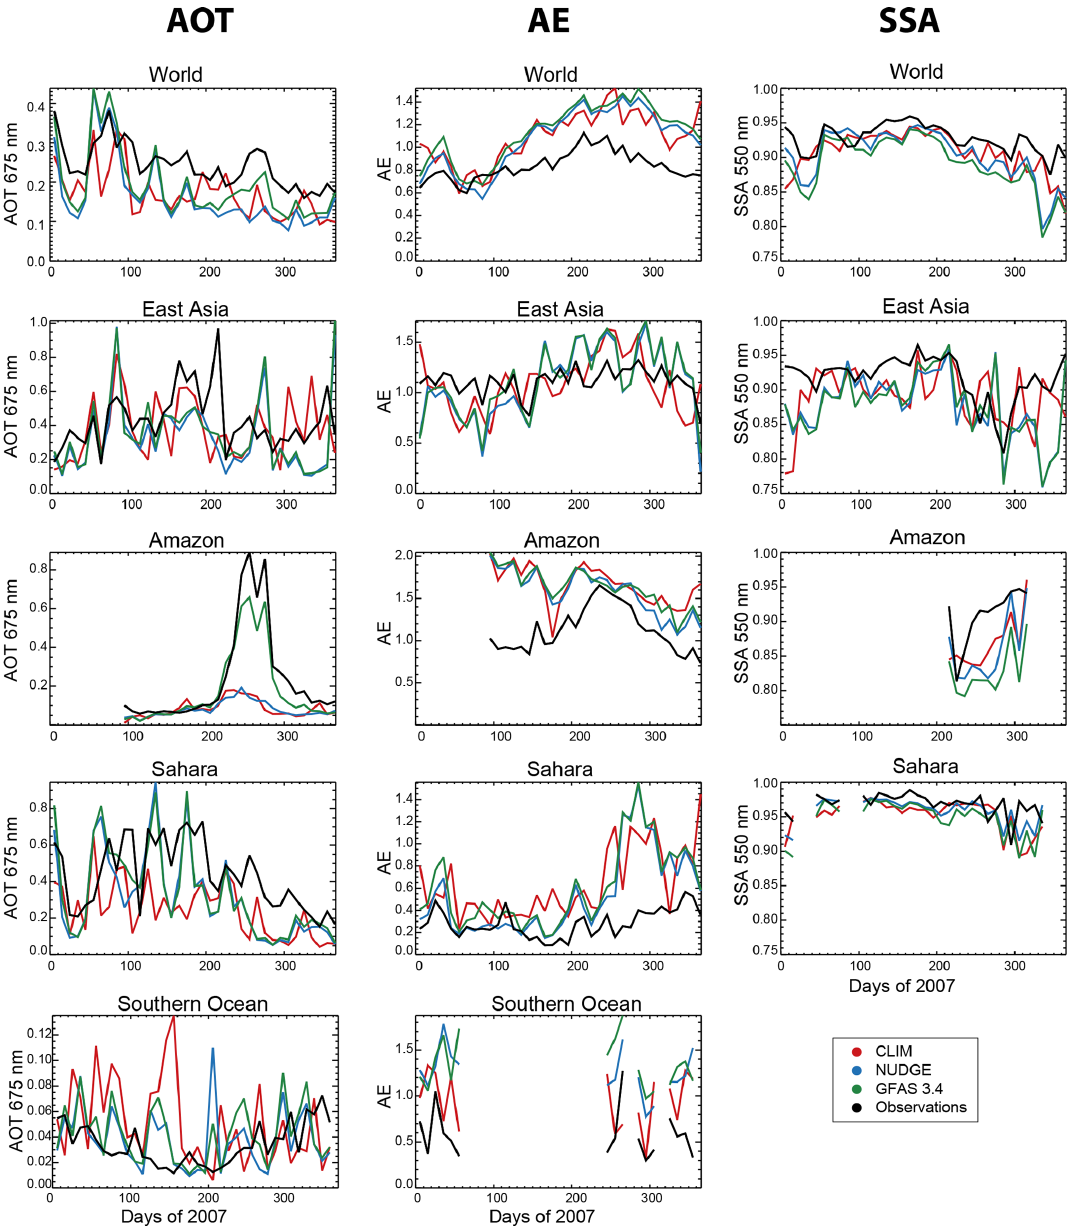
Figure 8. Annual cycle of AOT (left panels), AE (middle panels), and SSA (right panels) from AERONET retrievals as global averages and summarized for several regions (the world, East Asia, Amazon, the Sahara, and the Southern Ocean) as shown in Fig. 7 for the year 2007.